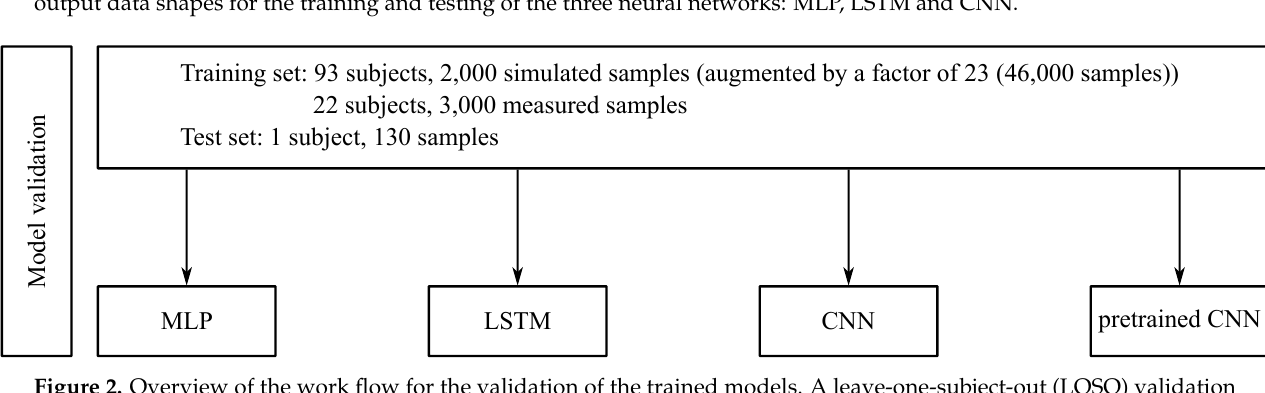
Figure 1. Exemplar overview of the work flow for the determination of the kinematics hyperparameters. First, the dataset consisting of 3D acceleration and 3D angular rate of five inertial sensors, and bilateral hip, knee and ankle joint 3D joint angles is split into training and test sets. Different preprocessing steps are then undertaken to create appropriate input and output data shapes for the training and testing of the three neural networks: MLP, LSTM and CNN.